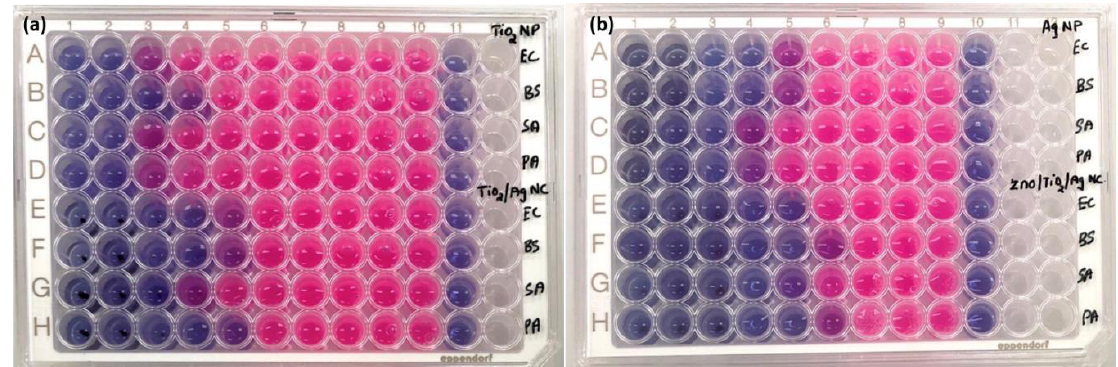
Figure 6. ( a ) Metabolic changes of bacterial pathogens of E. coli, B. subtilis, S. aureus and P. aeruginosa caused by TiO 2 NPs (rows A – D) and TiO 2 /AgNCs (rows E – H). ( b ) Bacteria treated with AgNPs (rows A – D) and ZnO/TiO 2 /AgNCs (rows E – H).